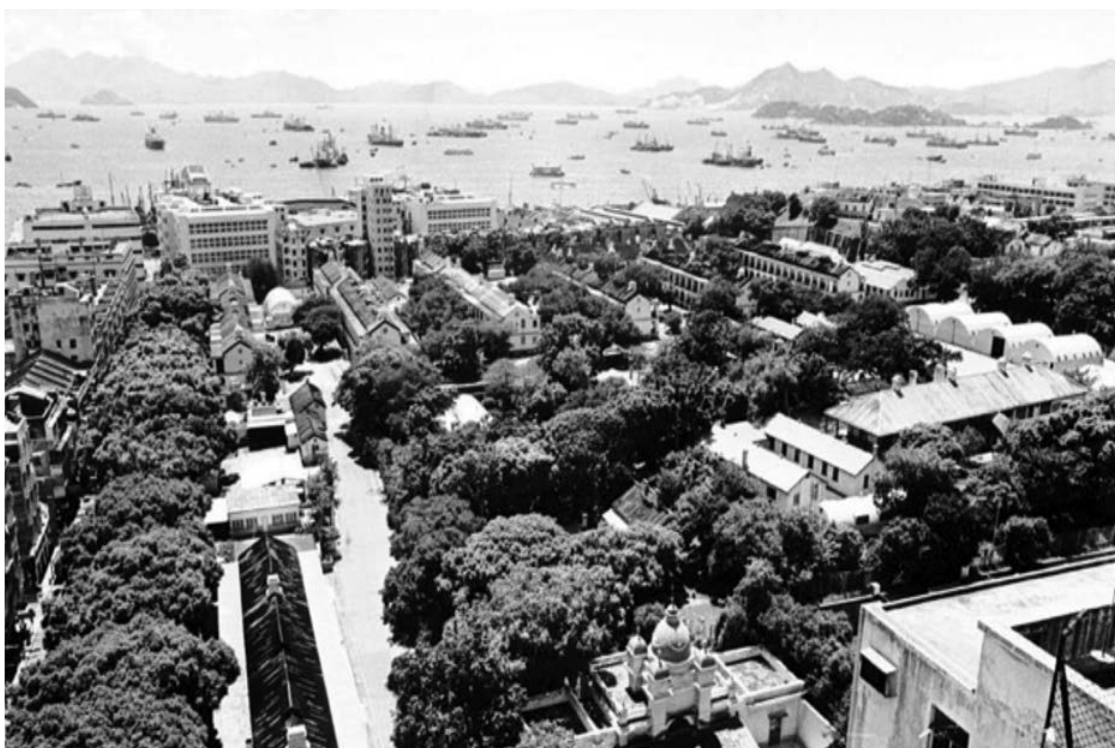
Figure 1: Kowloon Park with the Whitfield Barracks, 1968. Source: Lin 2018 . Figure 2: (opposite page) Kowloon Park. Source: Google